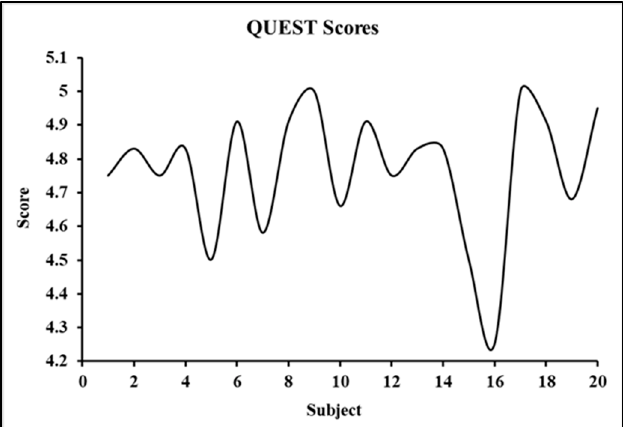
Figure 13. QUEST total scores